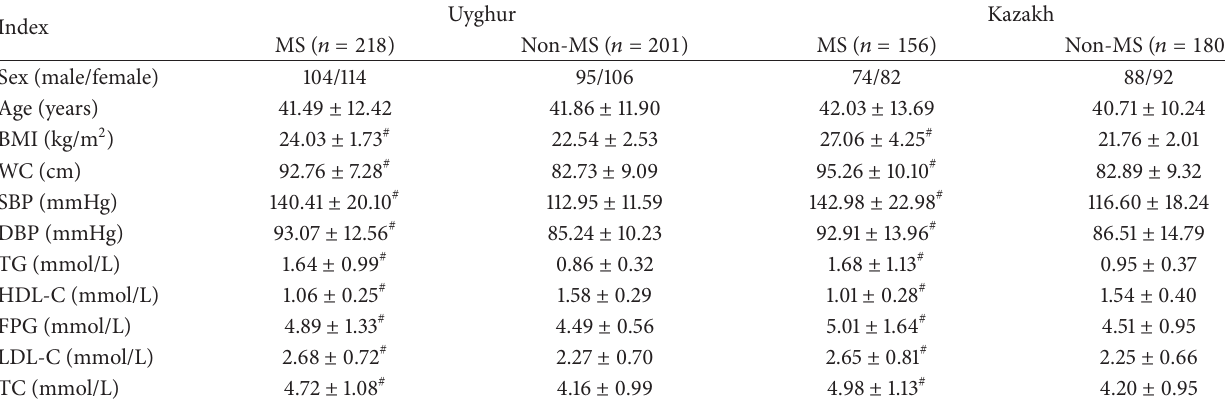
Table 1: Age and gender data for the Uyghur and Kazakh subjects.